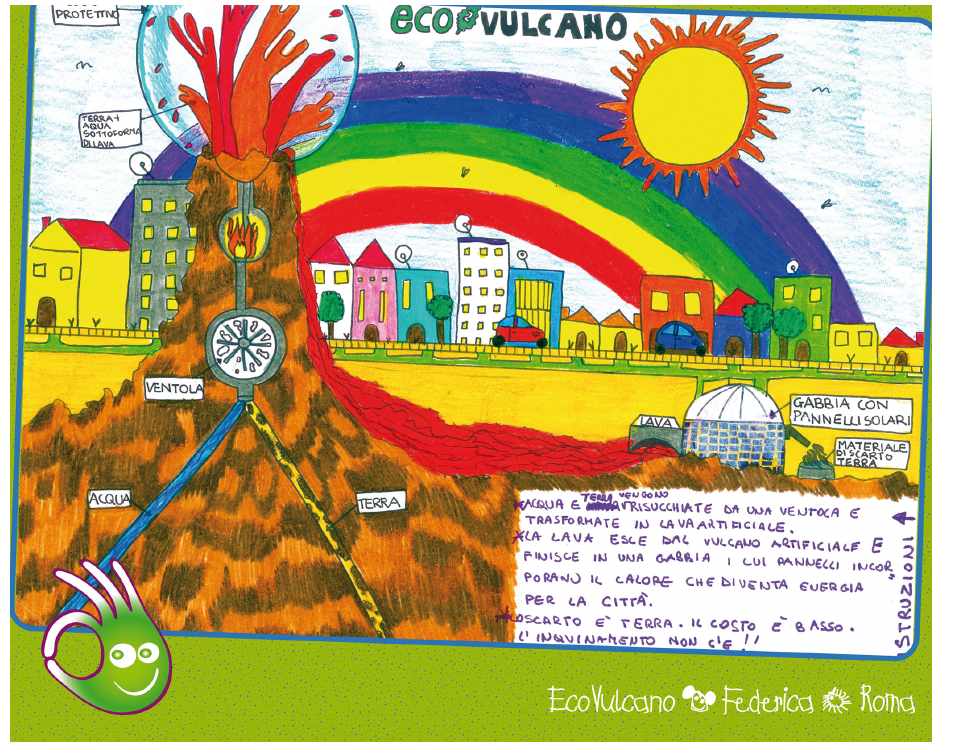
Figure 5. One of the drawings selected for the 2012 calendar. The drawing shows a very complex project of an eco-volcano, with very detailed instructions and precise statements on the low cost of the project and on the absence of pollution (edited by INGV Laboratorio Didattica e Divulgazione Scientifica and INGV Laboratorio Grafica e